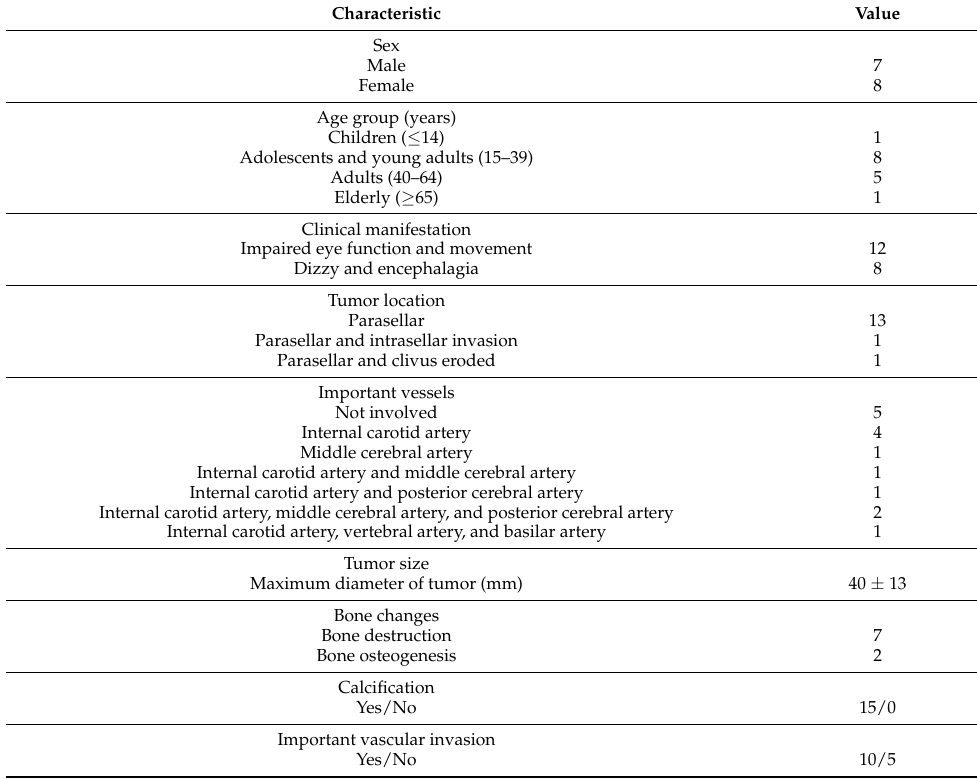
Table 1. Summary of preoperative clinical and radiological features in 15